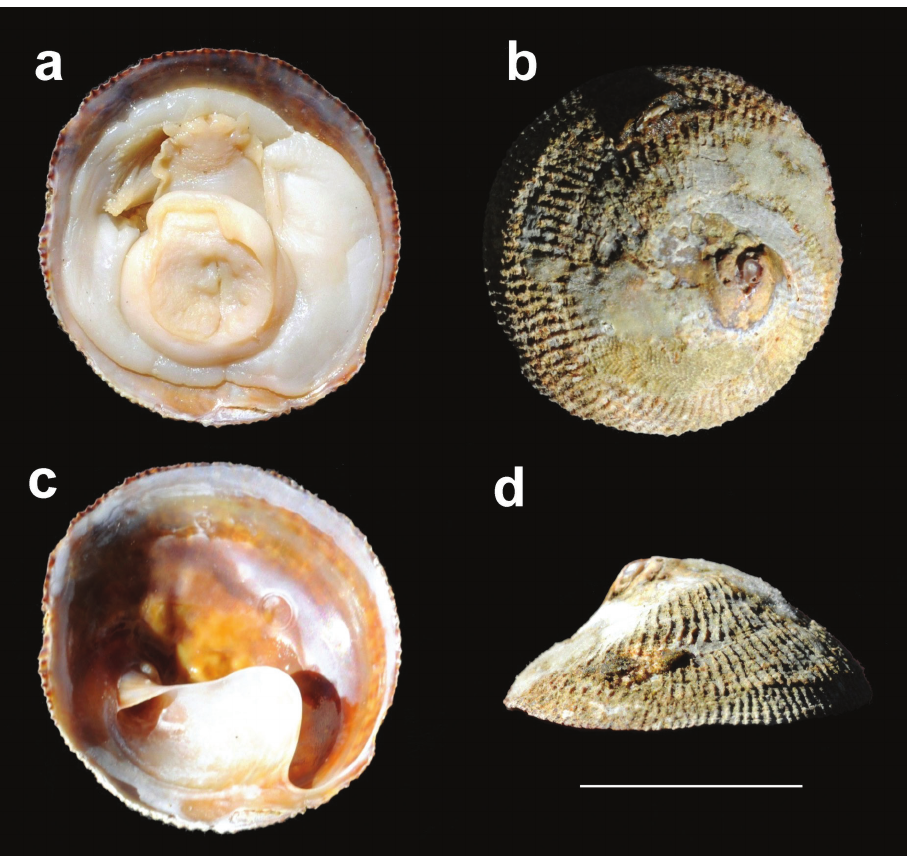
Figure 4. Calyptraea aurita . MNHNCL 7570, female specimen. a ventral view of shell and head–foot b dorsal view c ventral view d lateral view. Scale bar: 2 Table 2. Shell length in mm of Calyptrea aurita sampled randomly at Yerbas Buenas. N = number of individuals sampled; SD = Standard Deviation.